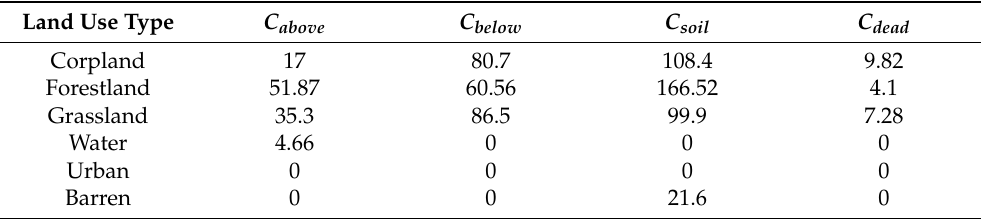
Table 1. Carbon density of land use types in Central Yunnan urban agglomeration (unit: t/hm 2 ). Land Use Type C above C below C soil